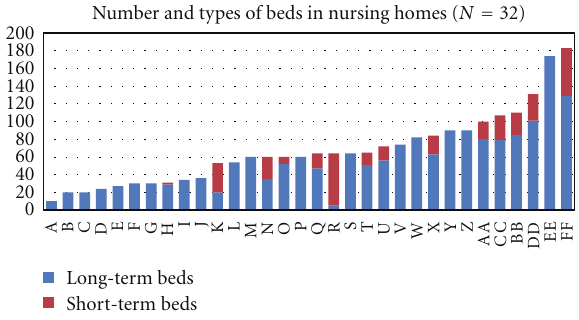
Figure 1: Size and proportion of long-term and short-term beds in all 32 nursing homes in the city of Bergen (250000 inhabitants), Norway. The red part indicates short-term beds (3-4 weeks stays) and the blue part long-term beds (permanent stays).